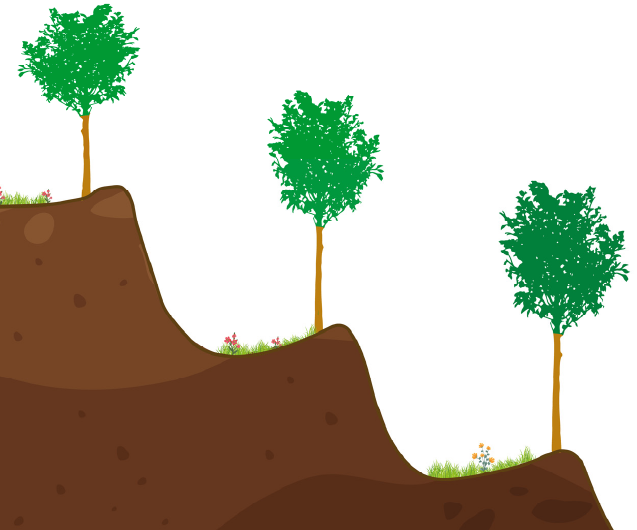
Figure 2. Schematic representation of the reversed slope terraces edified on the Braçal experimental catchment.